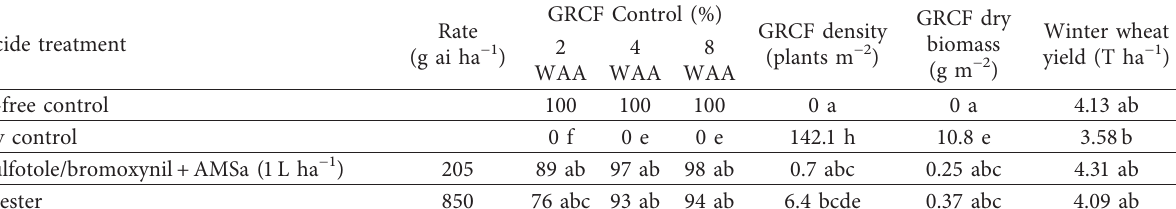
Pyrasulfotole/bromoxynil+AMSa (1L ha − 1